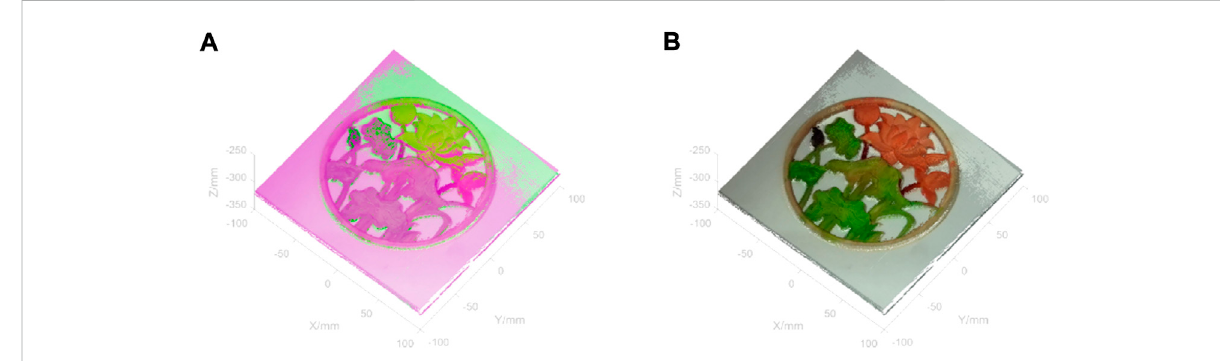
FIGURE 3 Registration results of two clusters of point clouds (A) registration results of point clouds (B) fusion results of two clusters of point clouds.